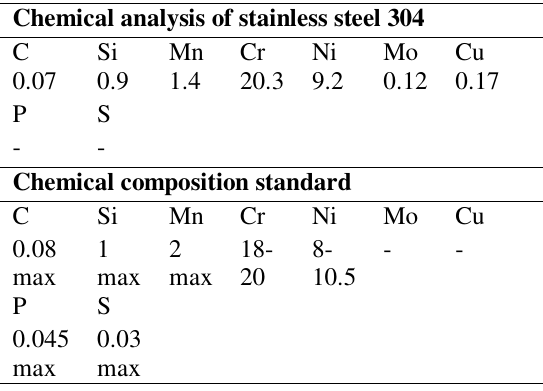
The chemical composition of the stainless steel 304.